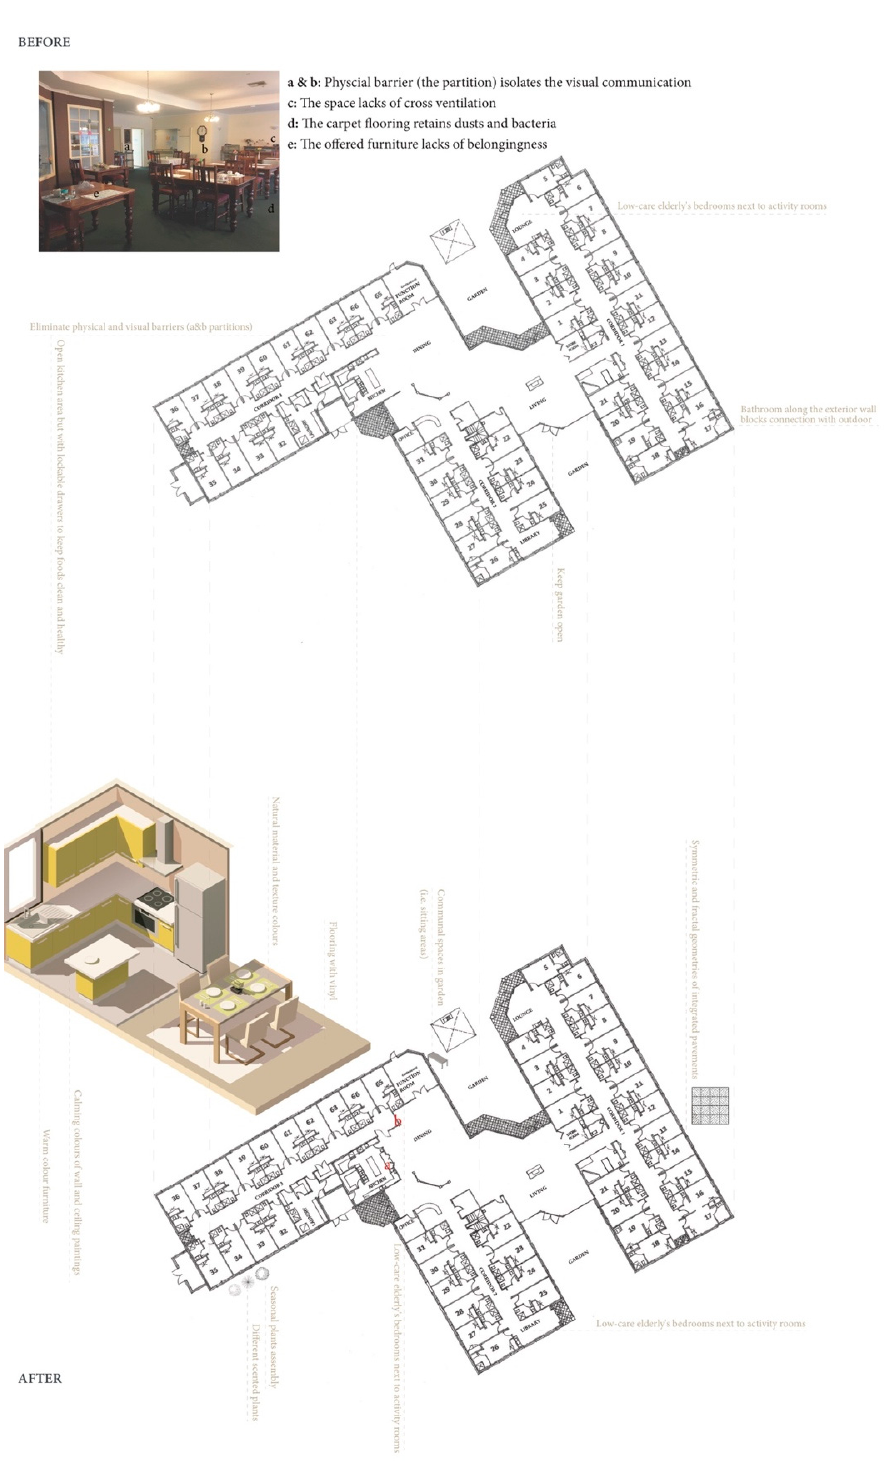
Figure 11. Proposed articulation for visual and physical connectivity between spaces.